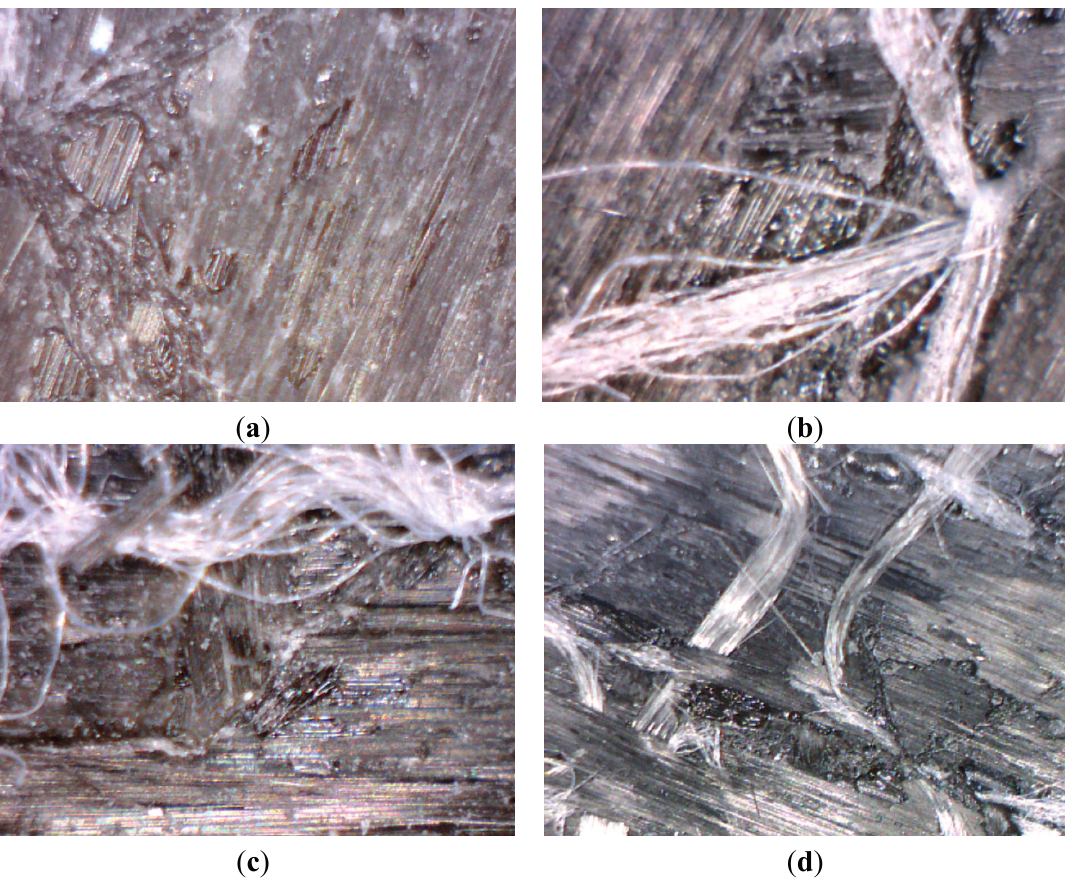
Figure 12. The fracture surface morphology of specimens containing ( a ) 0.0 wt%, ( b ) 0.5 wt%, ( c ) 1.0 wt%, and ( d ) 1.5 wt%